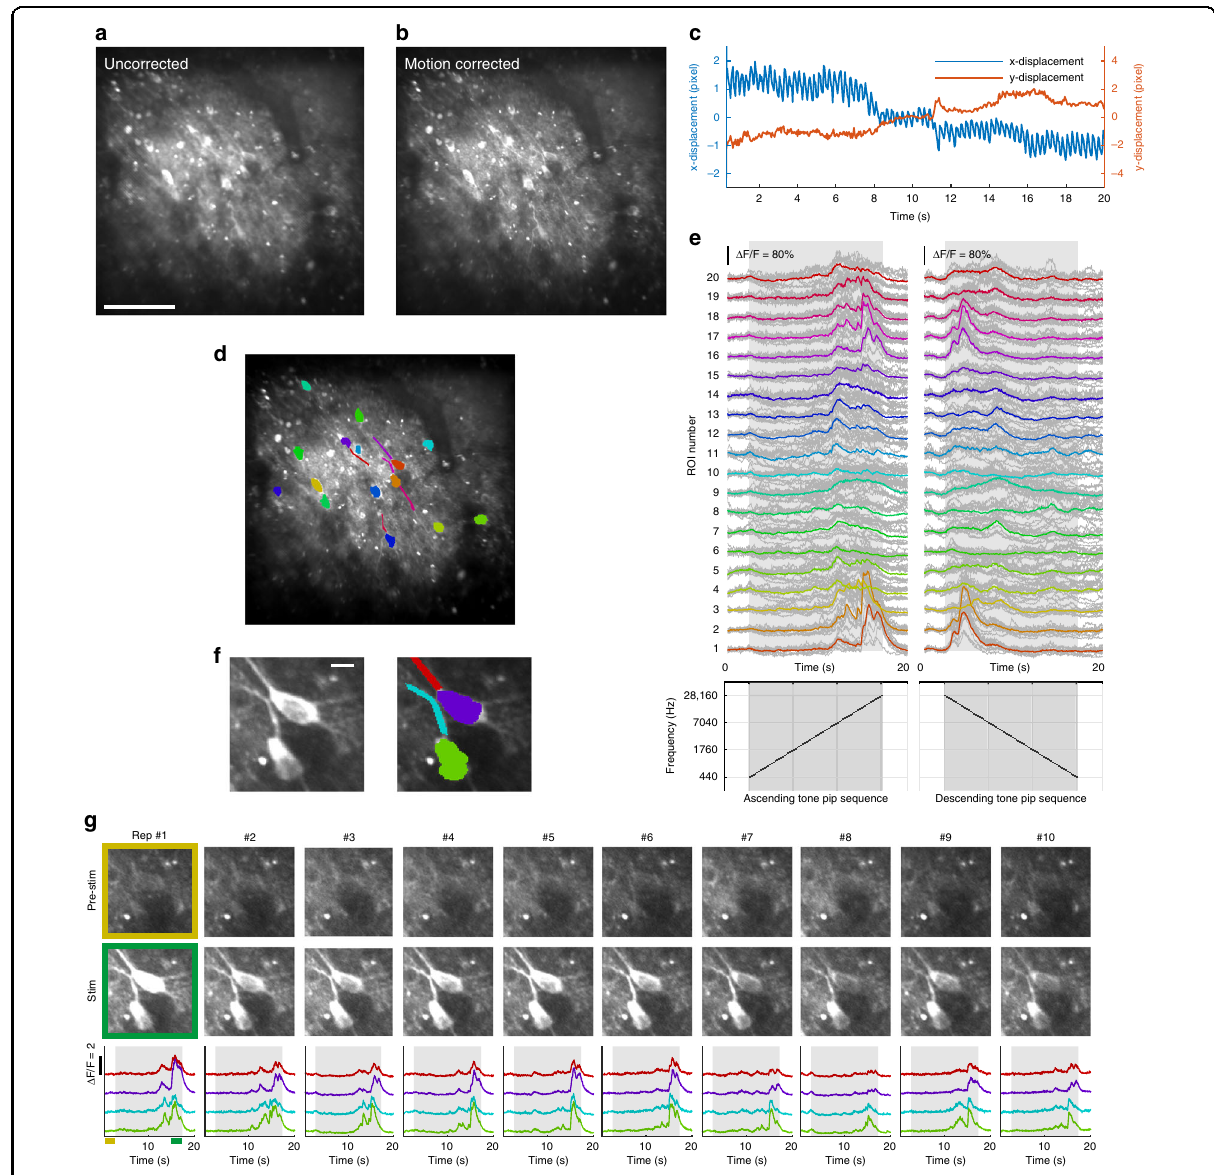
Fig. 3 Imaging auditory cortical neurons in awake marmosets at subcellular resolution. a A two-photon image directly averaged across all frames within a 20-s trial. Scale bar: 100 μ m. b An image averaged across the same trial with motion correction. c Estimated motion displacements along the x- and y- axes across the 20-second-long trial. d The exemplar ROIs of neuronal somas and processes in the FOV. e The calcium response traces of the ROIs labeled in ( d ) during the trials with both ascending (left) and descending (right) pure-tone pip sequences. The solid color lines indicate the mean response ( n = 10 repetitions). The light gray lines indicate responses in individual trials. f The zoomed-in FOV of ROIs for two neuronal somas and two neuronal processes. Scale bar: 10 μ m. g The individual-trial responses of the ROIs labeled in ( f ). The fi rst row of fl uorescence images shows the zoomed-in FOV during the pre-stimulus time. The second row shows the same zoomed-in FOV during the last 2.5 s of the stimulus presentation. The third row shows the response traces of the 4 ROIs following the same color scheme in ( f ). The integration time windows for deriving the images in the fi rst two rows were indicated under the fi rst panel in the third